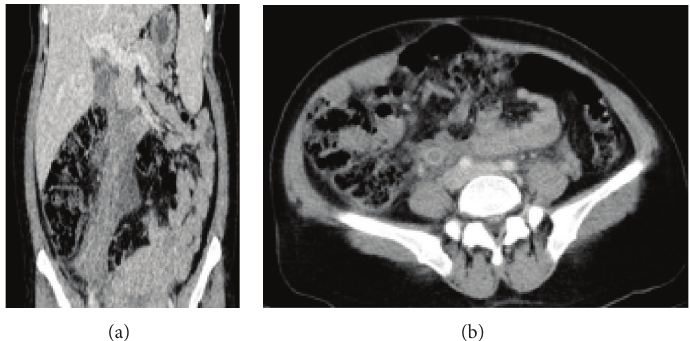
Figure 2: In coronal (a) and axial (b) CT images; enlarged ovarian vein, inflamed perivascular area, and thrombus in ovarian vein (OV) and inferior vena cava